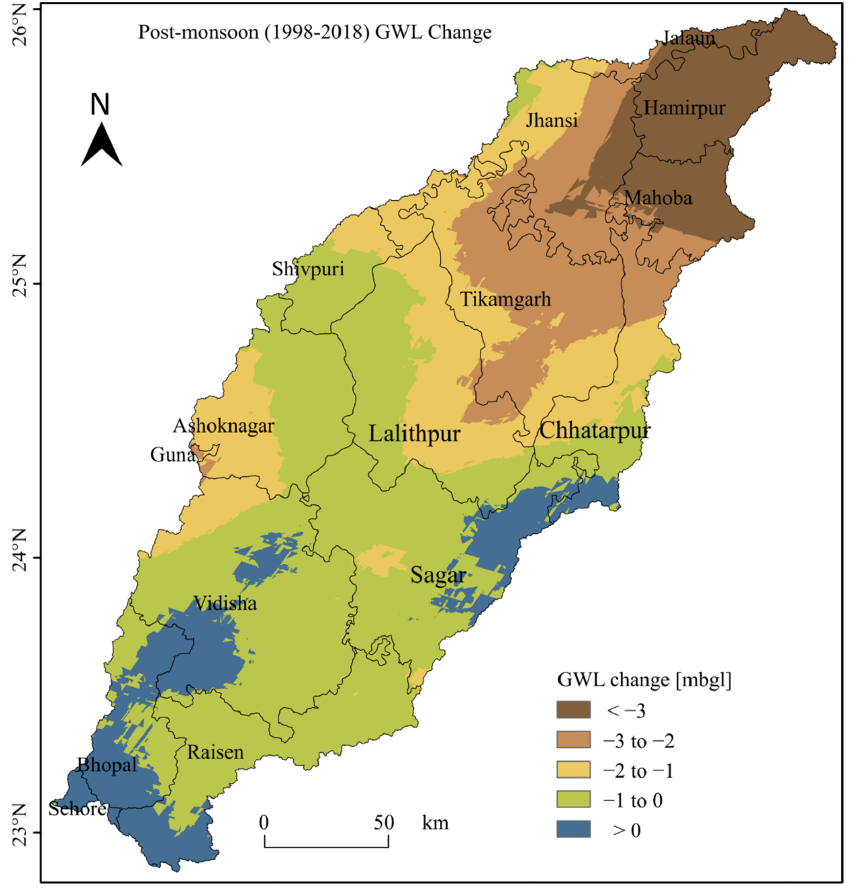
Figure 12. The spatial distribution of GWL change during the post ‐ monsoon period from 1998 to 2018. The polygons are the district administrative boundary. In addition, an increase in population (38%) in the northern districts (Hamirpur, Jhansi, Jalaun, and Mahoba) in the last two decades (1991–2011) has led to an expansion of built ‐ up and agricultural area by 0.2% and 4%, respectively, at the expense of forests (1.3%) and scrubland (25%) which might have impacted the GWL [31,74] (Figure 13a). The